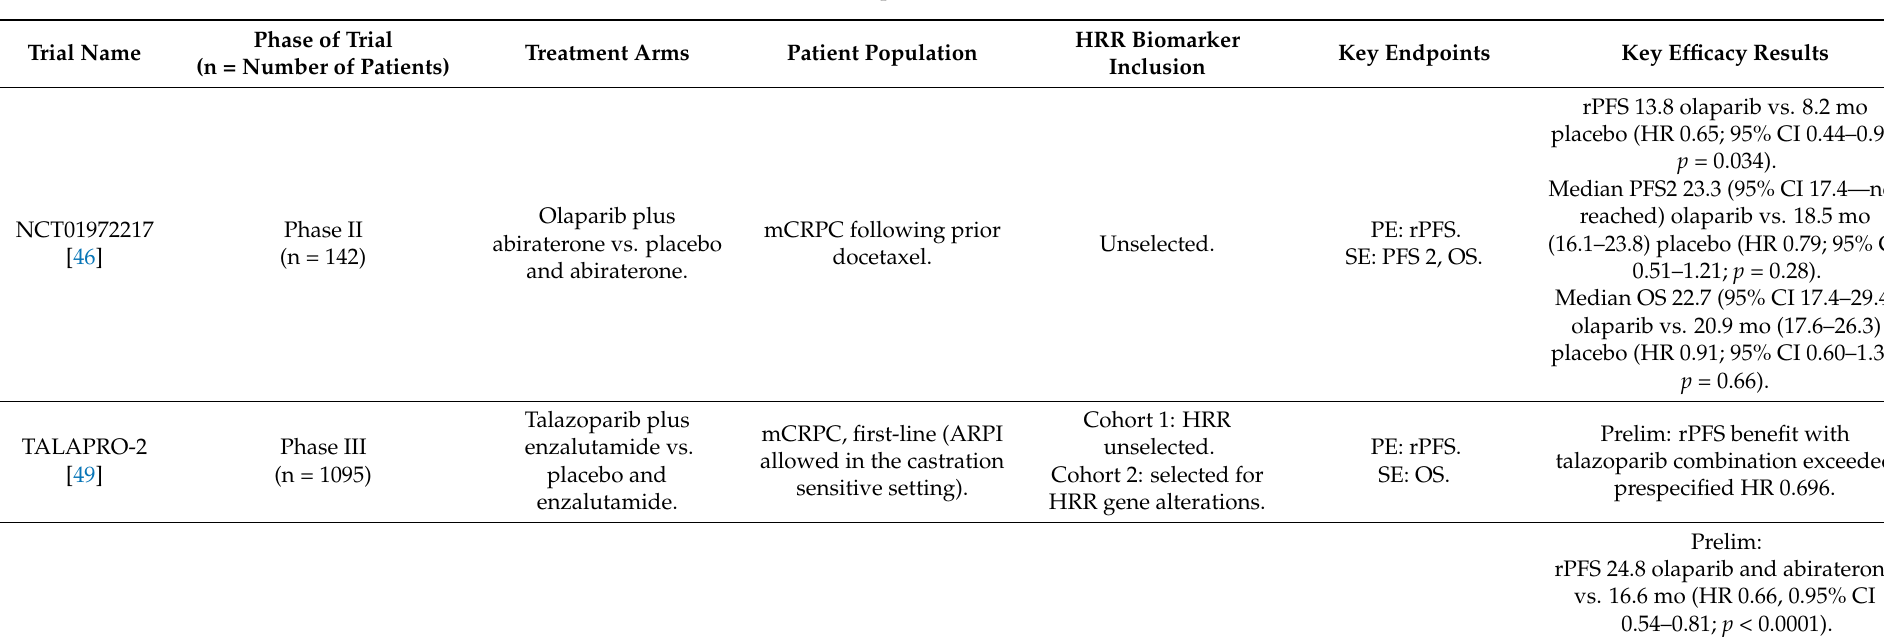
Table 2. Combination PARP inhibitor trials in metastatic prostate